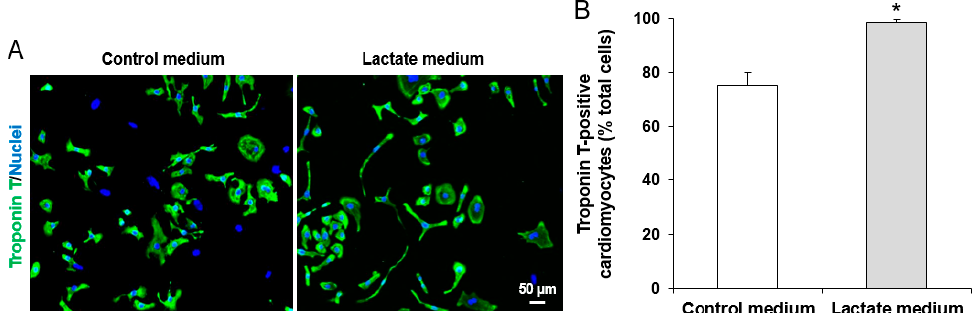
Figure 2. Lactate purification of 1013 iPSC-derived CMs. ( A ) The fluorescent images of iPSC-CMs (day 31) with or without treatment of lactate-contained purification medium (no glucose) for 7 days to eliminate non-cardiomyocytes. Blue are cell nuclei stained with Hoechst 33342 and green are troponin T signals. In the purified cell culture, almost all cells with blue nuclei expressed troponin T. Scale bar = 50 µm. ( B ) The purification of iPSC-CMs increased from 75% to 98% after culturing in lactate medium. Data are presented as mean ± SEM, n = 4 * p < 0.05 vs. control medium.